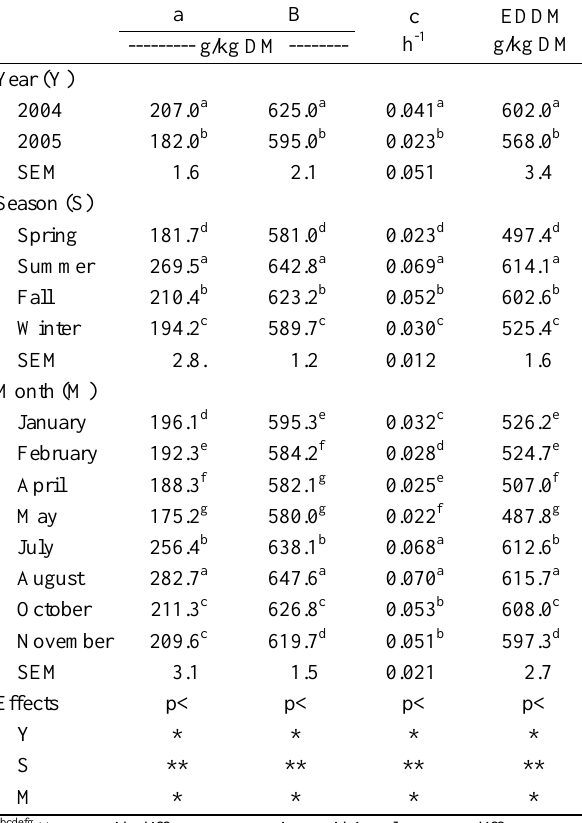
Table 6. In situ degradability and effective degradability of neutral detergent fiber of the diet consumed by grazing steers